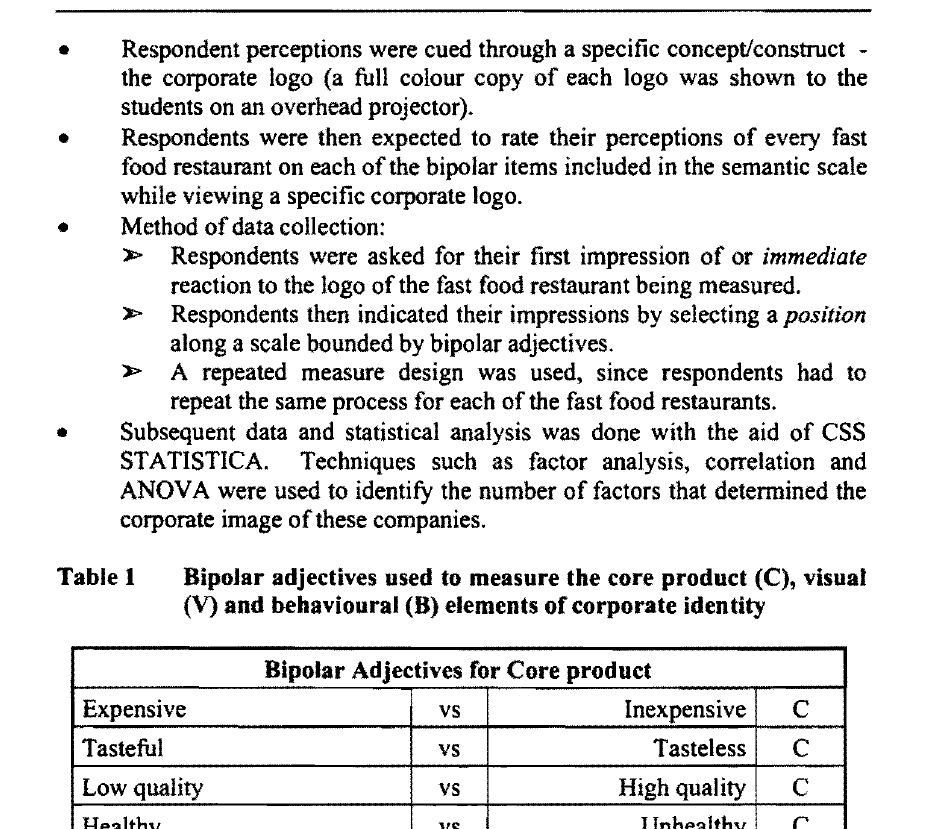
Bipolar adjectives used to measure the core product (C), visual (V) and behavioural (B) elements of corporate identity Bipolar Adjectives for Core